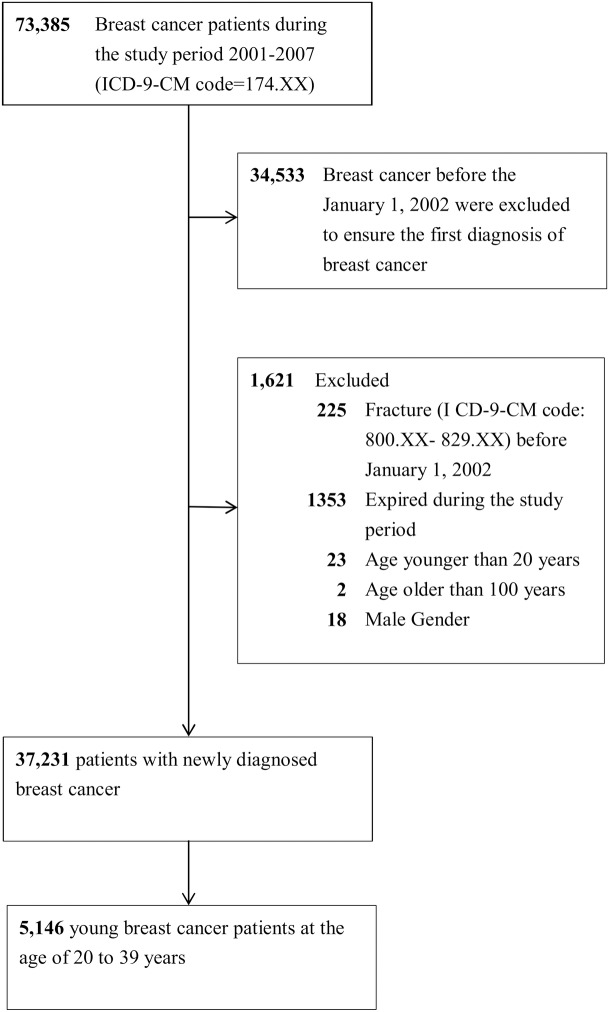
Selection of study patients.